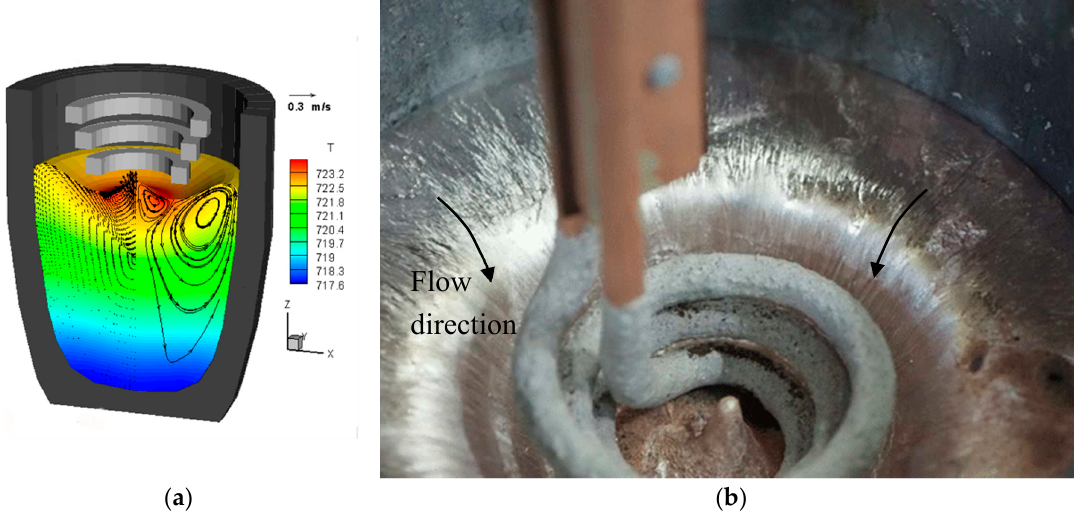
Figure 4. ( a ) Computed flow and heat transfer in a small 125 mm experimental crucible, containing A357 aluminium alloy used for particle tracking studies, ( b ) experiment showing the free surface of the melt; radial striations on the oxide layer indicate the flow direction and the conical elevation coinciding with the coil axis. Temperature contour range <717–723 °C>, maximum velocity 0.3 m/s.